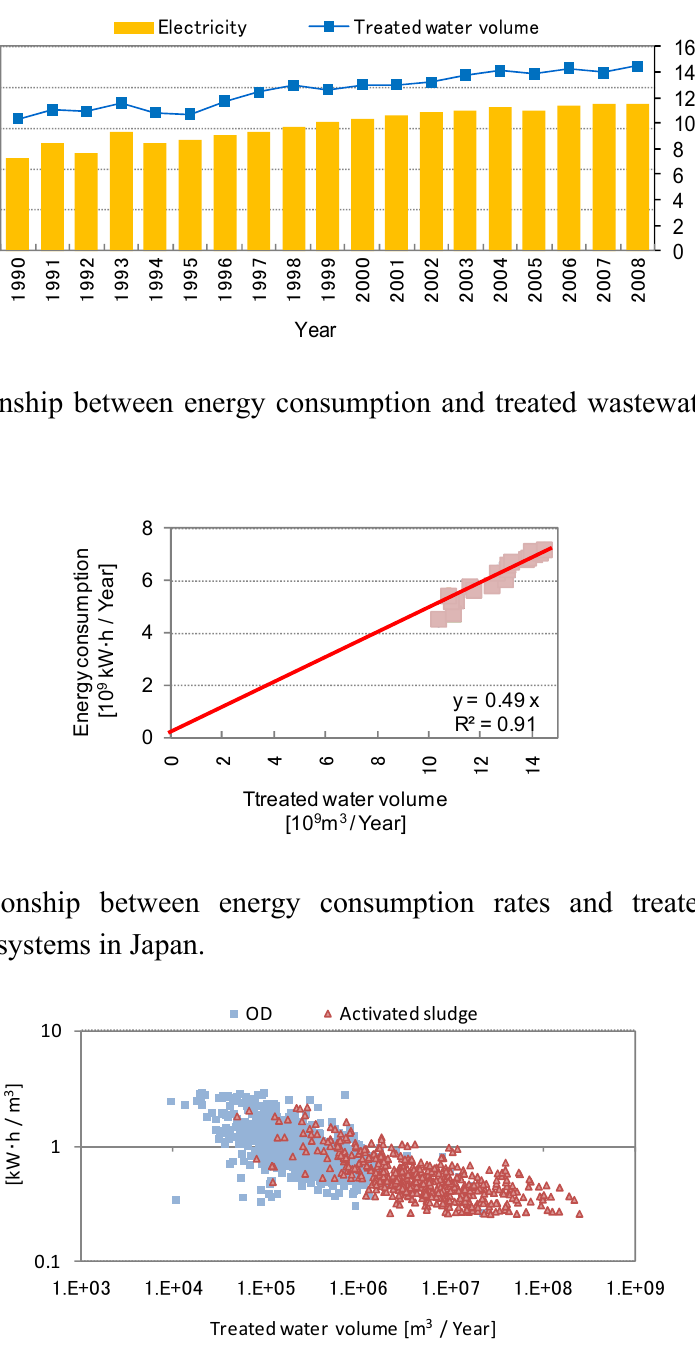
Figure 11. Treated wastewater volumes and electricity consumptions for all sewer systems in Japan.